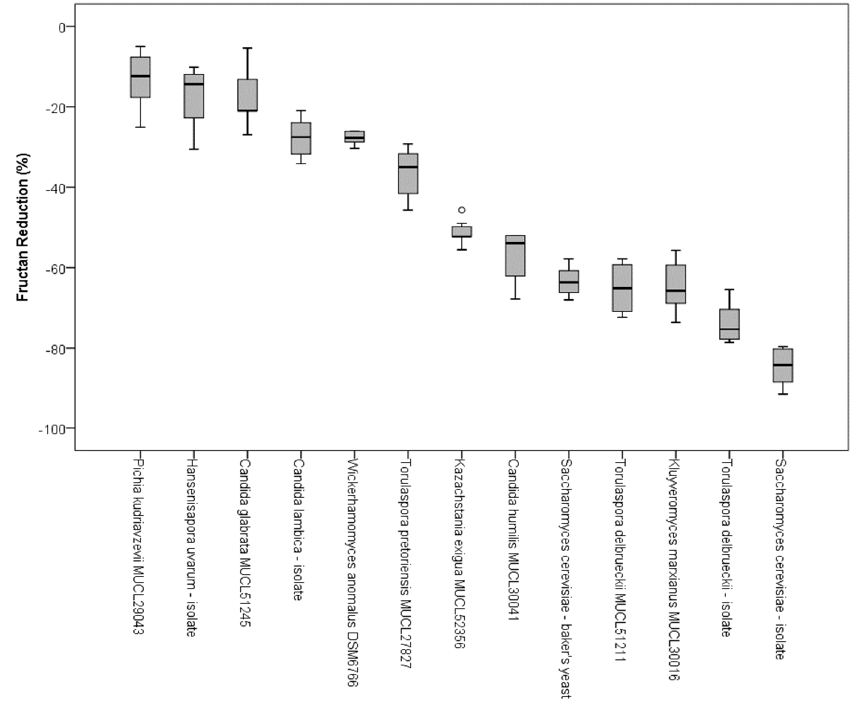
Figure 5. Box plots of the fructan reduction of examined yeast strains in wheat flour after 8 h and 15 min of incubation at 25 °C, determined according to the AOAC 999.3 standard; circles present outliners.